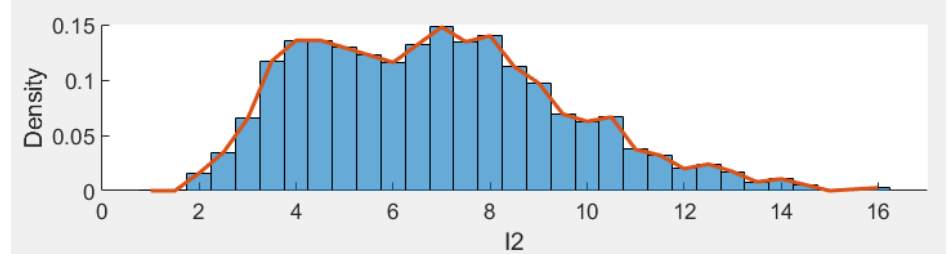
Figure 10. Histogram of the probability density function of I2(t).